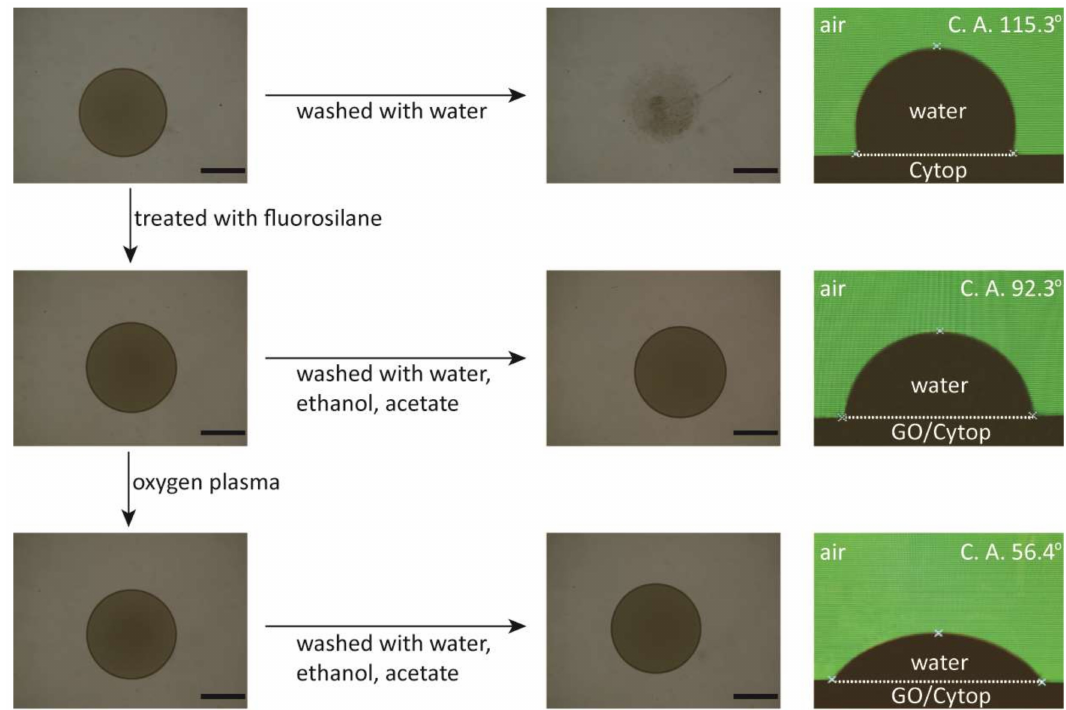
Figure 4. Left and center columns: Optical images of the graphene oxide thin films on Cytop with fluorosilane treatment and then oxygen plasma treatment. Right column: The images from the optical tensiometer for the contact angle measurements. Scale bars: 5 mm.